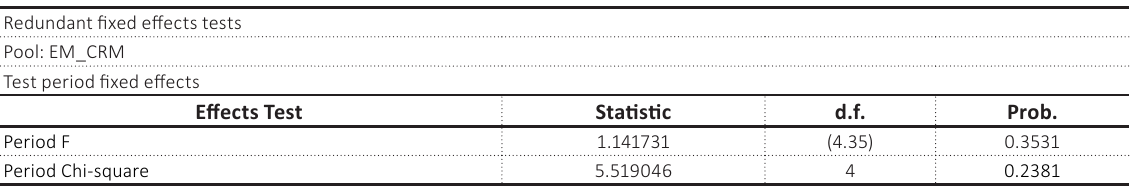
Table 4. Chow test results of earnings management as a dependent variable